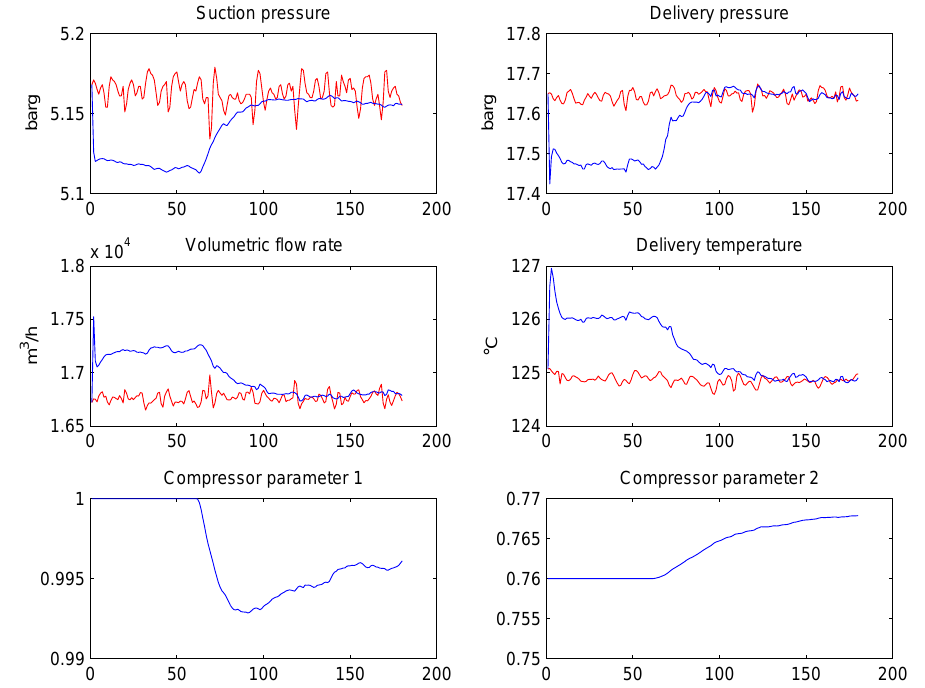
Figure 4: State and parameter estimation of one of the compressor stages. Red lines are real process data, and blue lines are estimated results. State estimation is turned on after 60